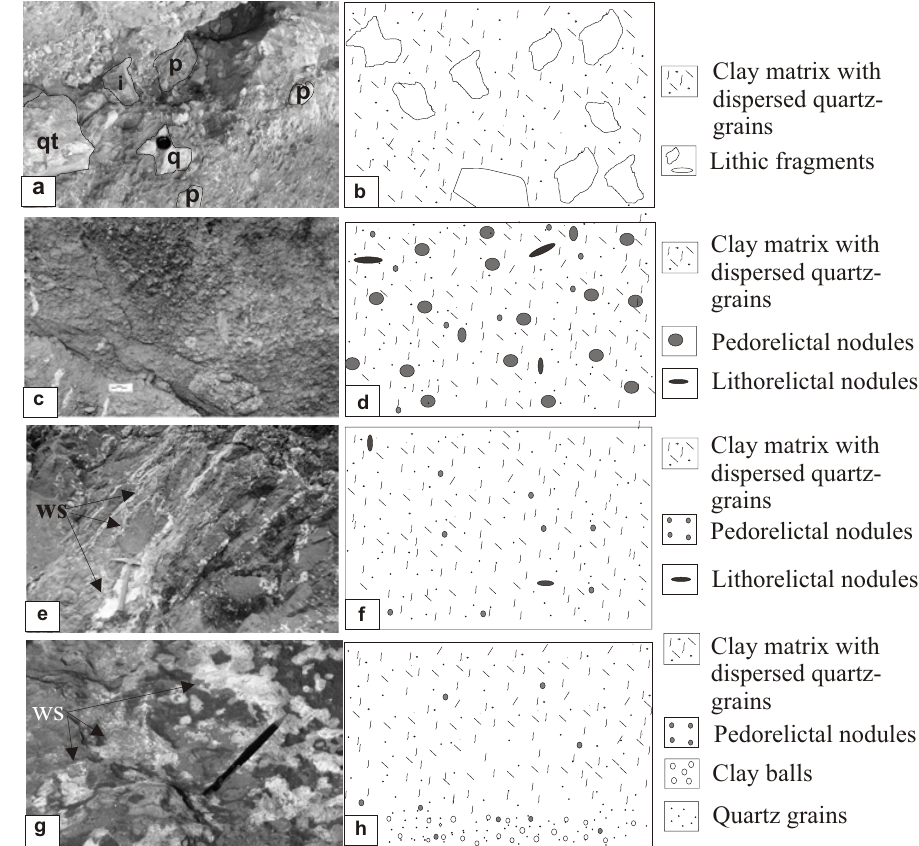
Fig. 3 – Photographs and schematic representation of the facies. a) and b) Fragmentary facies (Fr) showing the lithic fragments: quartz vein (q), quartzite (qt) phyllite (p) and itabirite (i); c) and d) nodular facies (N) showing nodules of different sizes dispersed in a clayey matrix; e) and f) massive clayey facies (Mc) showing the plans of fractures surrounded by white stains (ws); g) and h) friable clayey facies (Fc) showing white stains (ws) in gradational contact with a dark-red clayey